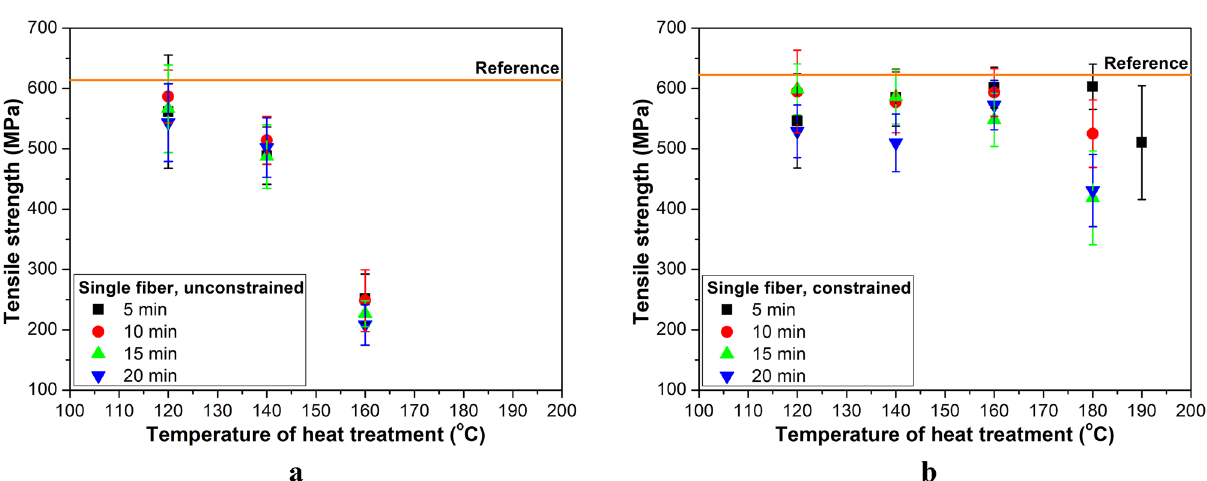
Figure 6. Tensile strength of single fibers as a function of heat treatment temperature for different treatment times: in the case of free ( a ) and constrained ( b )